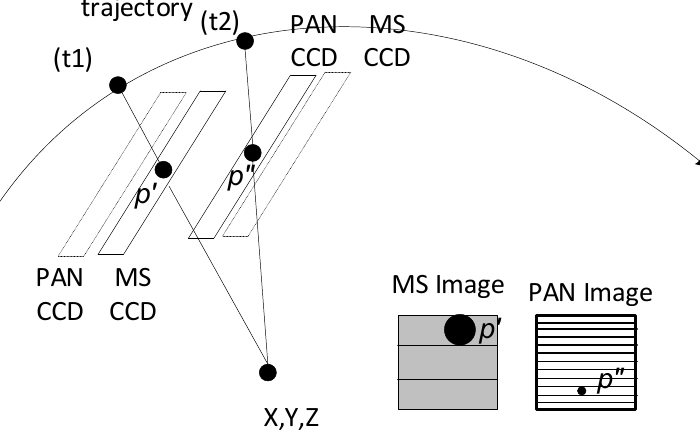
Figure 2. MS and PAN capture the same target in the images at different times because of CCD